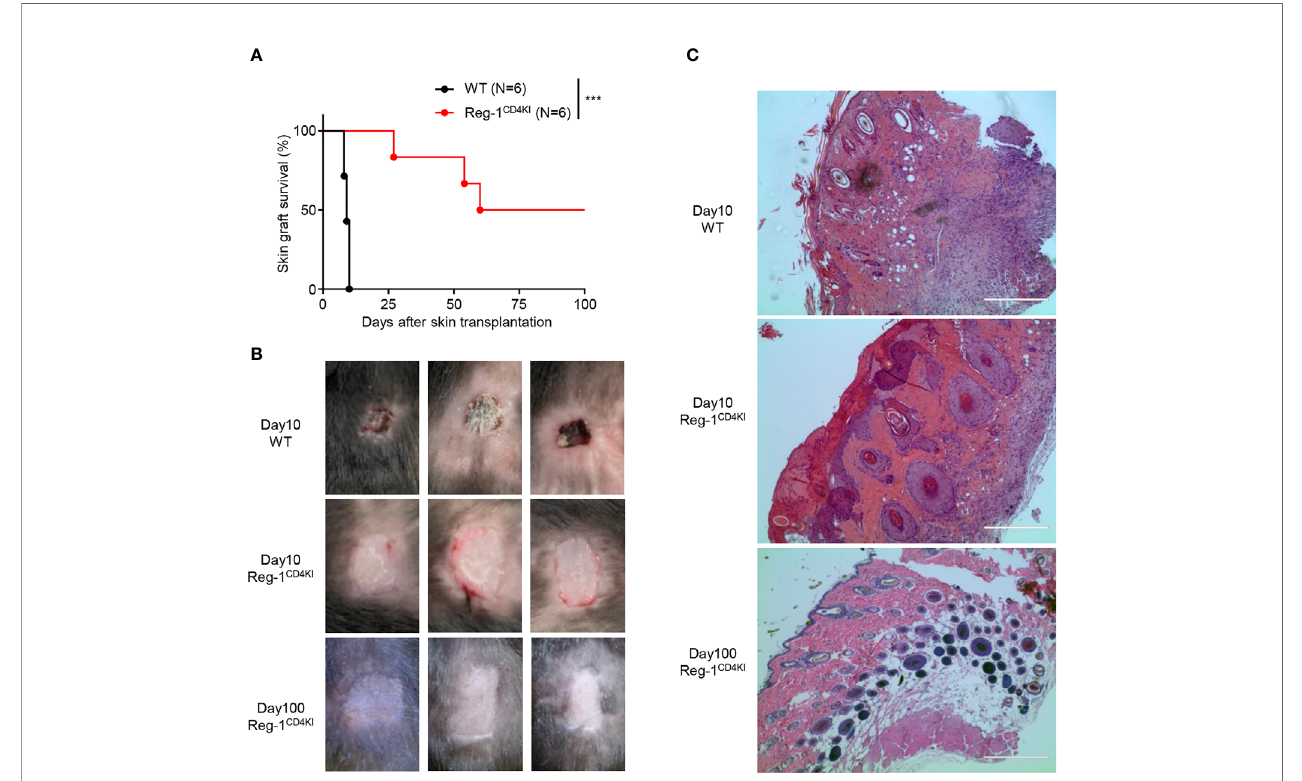
FIGURE 3 | Regnase-1 promotes graft survival in skin transplantation model. (A) The percentage of skin allograft survival on WT or Reg-1 CD4KI recipients. ***P < 0.001; Log-rank test. (B) Representative images of BALB/c skin allografts at day 10 on WT recipients, and day 10 and 100 on Reg-1 CD4KI recipients. (C) Representative H&E staining images (×100) of BALB/c skin grafts at day 10 from WT recipients, and day 10 and day 100 from Reg-1 CD4KI